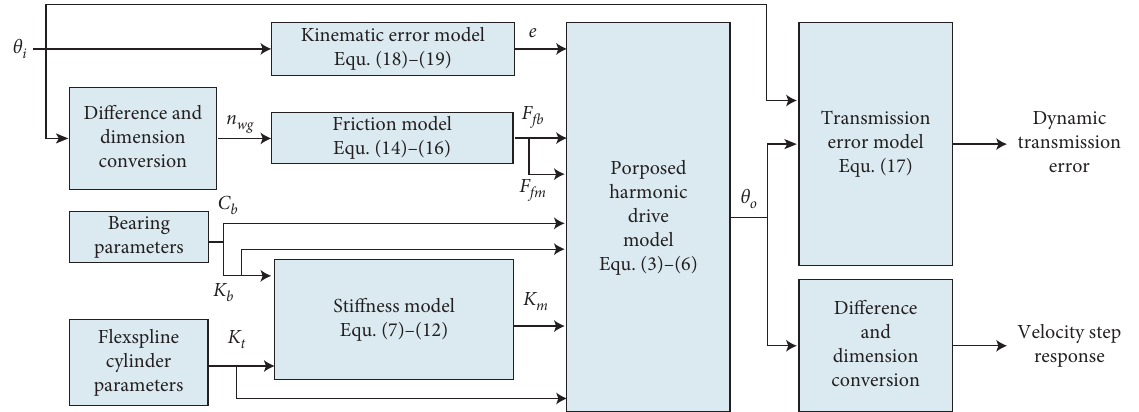
Figure 9: Simulation block diagram of the harmonic drive